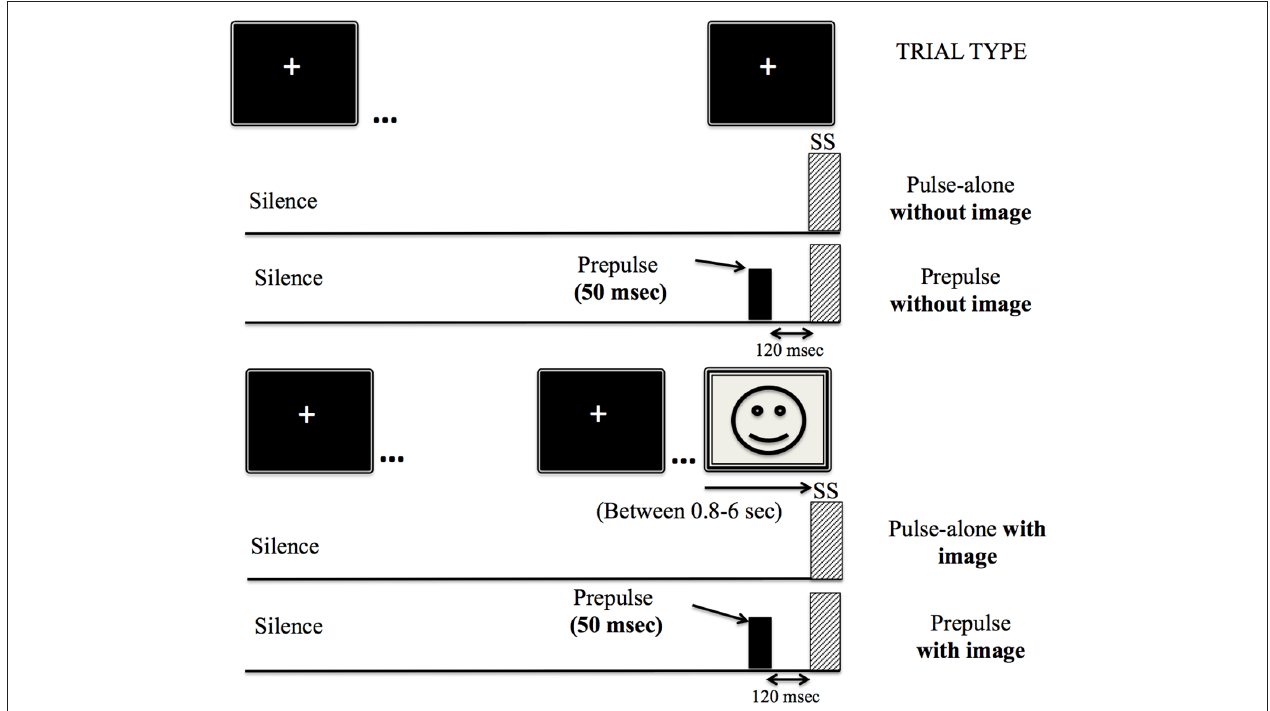
FIGURE 1 | Schematic representations of startle and prepulse